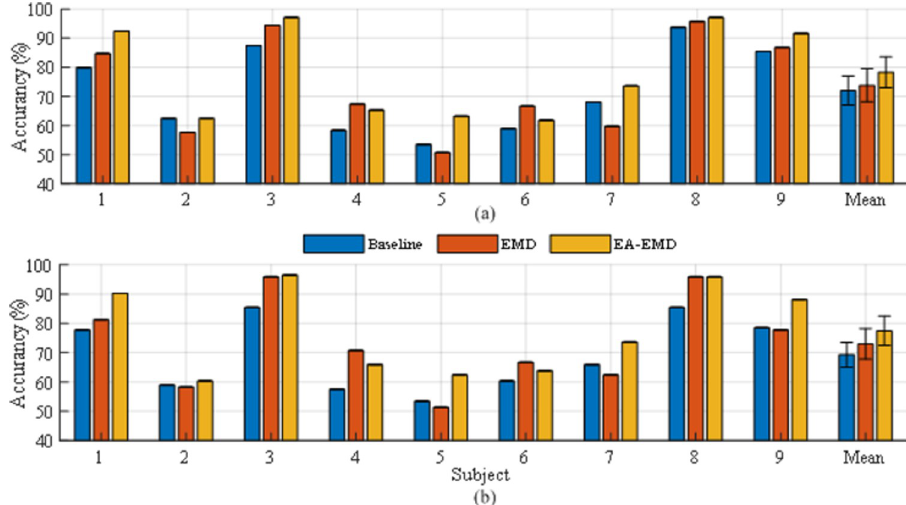
Fig 7. Classification accuracies of the nine subjects in data set 1 achieved by 20 training trails per class using (a) LDA and (b) LR as the classifier. The error bars represent standard errors.